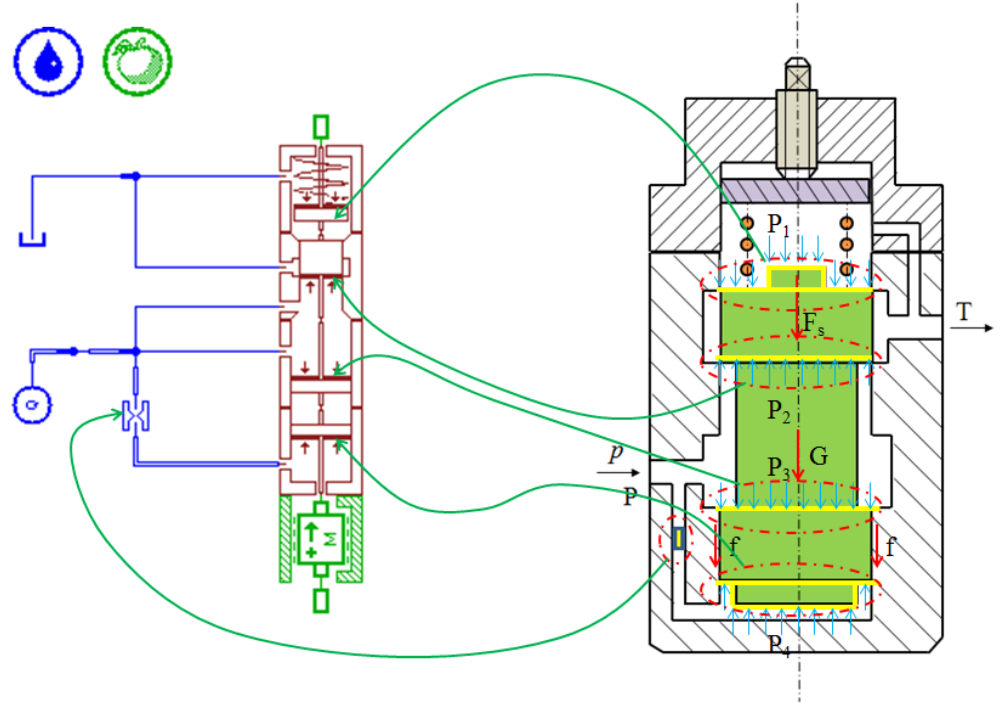
Figure 9. AMESim simulation model of the SVTDARVWEO.